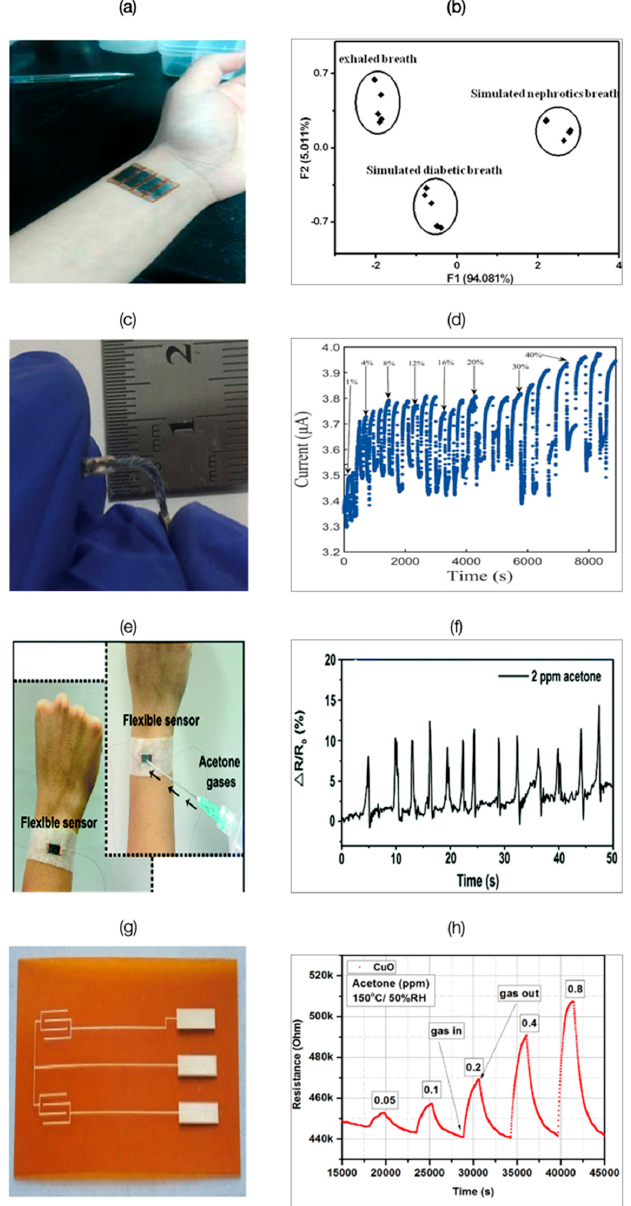
Figure 11. ( a , b ): On-body Sensor ( a ) Photograph of the as-prepared multifunctional wearable device mounted on the human wrist for simultaneously monitoring VOC-related disease; ( b ) PCA of exhaled breath of simulated nephrotics patients, diabetic patients, and healthy people. Reprinted with permission from [117]. Copyright (2018), American Chemical Society. ( c , d ): In-clothing type sensor; ( c ) Camera image of a cotton thread with PEDOT:PSS; ( d ) Signal–response curve to acetone at different concentrations. Sensing experiment for each concentration is repeated three times with the sensor (n = 3). Reprinted with permission from [118]. Copyright (2016), The IOPscience; ( e ) Photo- graph of a proof-of-concept wearable sensor and illustration of the performance evaluation method. ( f ) Real-time sensor response to a pulsated ejection of simulated diabetic breath containing 2 ppm of acetone vapor (85% RH) flown directly over the sensor. Reprinted with permission from [119]. Copyright (2013), The Royal Society of Chemistry; ( g ) Resistance changes for Kapton-based CuO